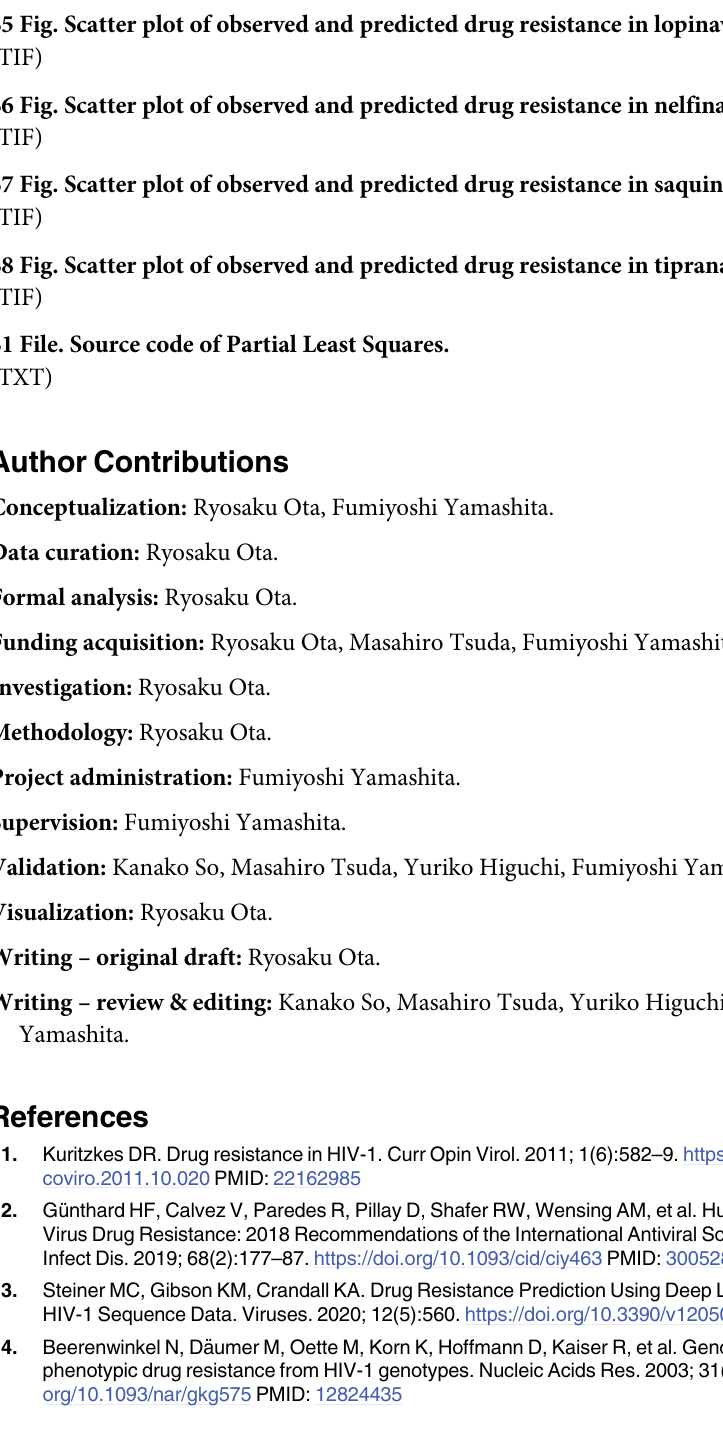
S3 Fig. Scatter plot of observed and predicted drug resistance in fosamprenavir. (TIF) S4 Fig. Scatter plot of observed and predicted drug resistance in indinavir. (TIF) S5 Fig. Scatter plot of observed and predicted drug resistance in lopinavir. (TIF) S6 Fig. Scatter plot of observed and predicted drug resistance in nelfinavir. (TIF) S7 Fig. Scatter plot of observed and predicted drug resistance in saquinavir. (TIF) S8 Fig. Scatter plot of observed and predicted drug resistance in tipranavir. (TIF) S1 File. Source code of Partial Least Squares.